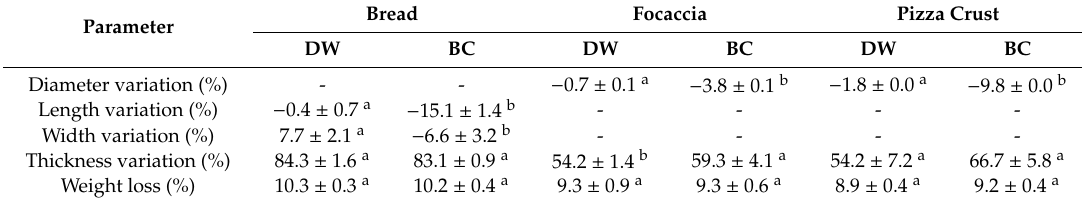
Table 7. Baking-induced variations of the dimensional parameters of conventional durum wheat bread, focaccia, and pizza crust and of their black, chickpea-enriched versions. DW = product prepared by using durum wheat re-milled semolina; BC = product prepared by using a composite meal